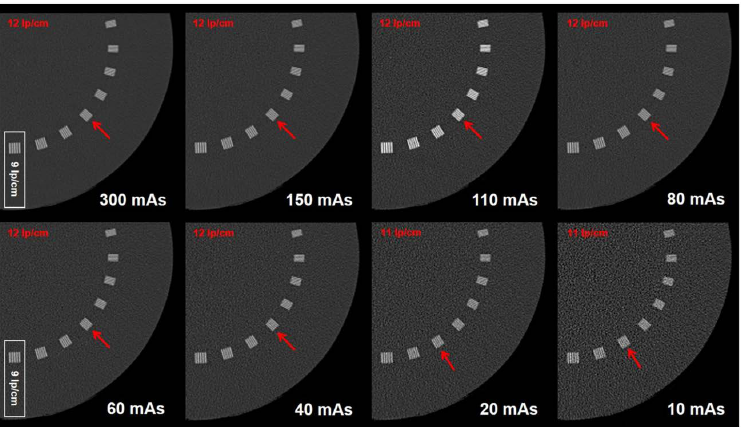
Figure 4. The images show the high-contrast resolution (red arrows) using a Catphan ® Phantom (The Phantom Laboratory) for the phantom study at different tube current levels, thereby continuously decreasing the tube current in eight steps from 300 mA (reference standard) to 10